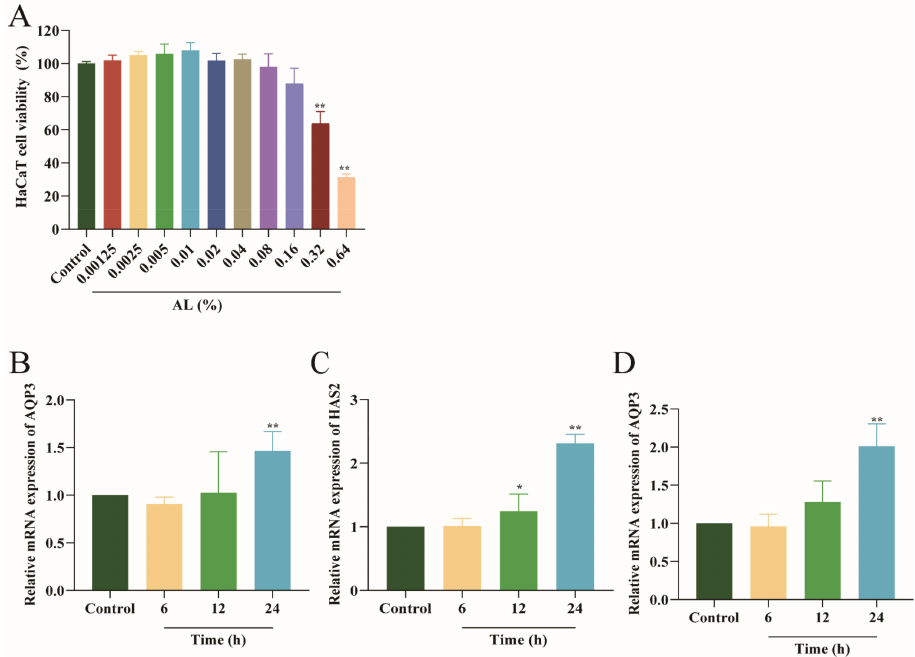
Figure 1. Effects of different AL treatment concentrations and times on HaCaT cells. ( A ) HaCaT cells treated with AL (0.00125~0.64%) for 24 h. The mRNA expression of AQP3 ( B ), HAS2 ( C ), and HAS3 ( D ) in HaCaT cells treated with 0.02% AL for different times. Results are expressed as means ± SDs of three independent experiments. ** p < 0.01, * p < 0.05 compared to the normal group (no treatment). One-way ANOVA was used to evaluate significance.